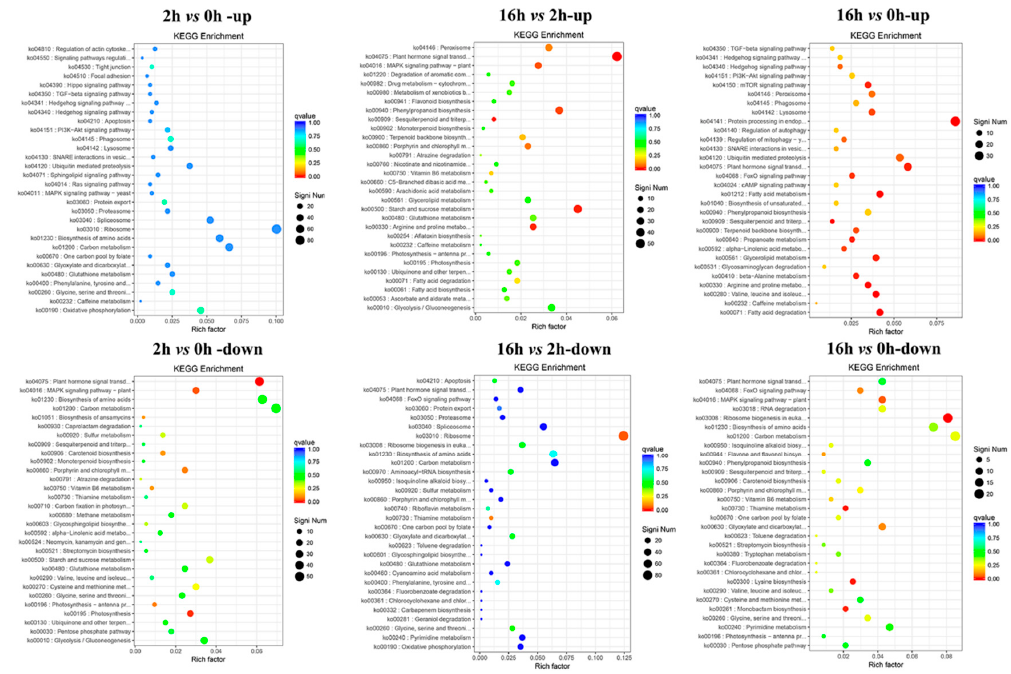
Figure 6. Kyoto Encyclopedia of Genes and Genomes (KEGG) enrichment of up- and down-regulated Figure 4. Kyoto Encyclopedia of Genes and Genomes (KEGG) enrichment of up- and DEGs during the drought down-regulated DEGs during the drought period.